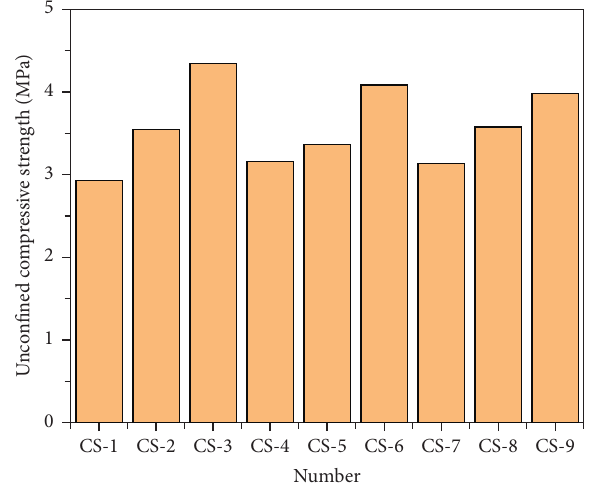
Figure 7: 28-day compressive strength of cement-stabilized coral